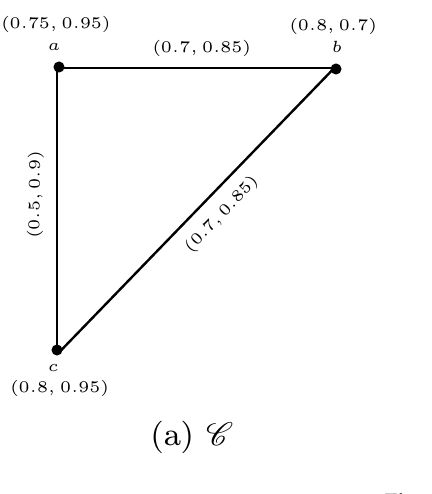
Figure 16. ( a ) C ; ( b ) H